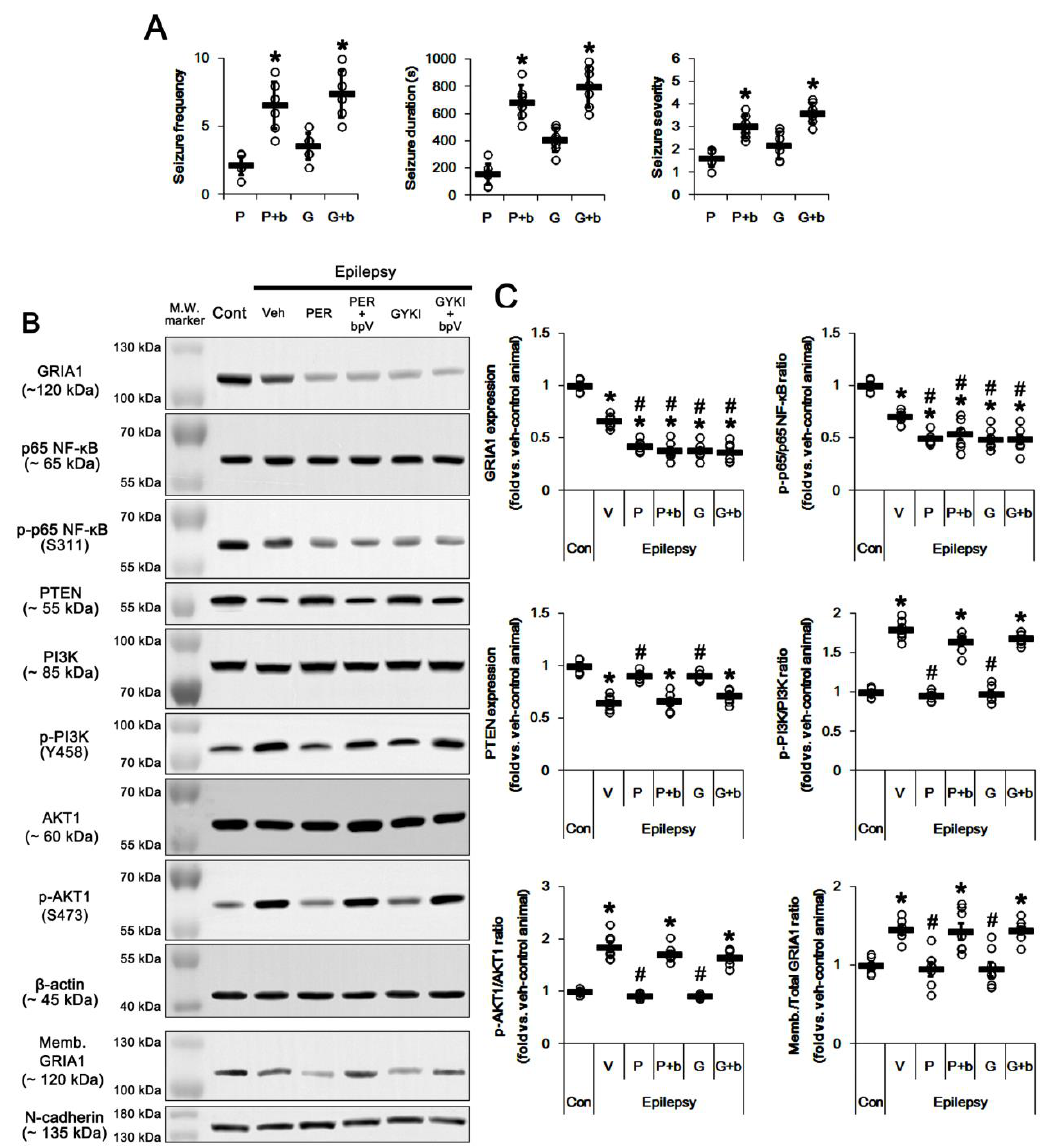
Figure 7. The e ff ect of co-treatment of dipotassium bisperoxovanadium(pic) dihydrate (BpV(pic)) (bpv, b) with perampanel (PER, P) or GYKI 52,466 (GYKI, G) on spontaneous seizure activity, total / membrane GRIA1 expressions, PI3K / AKT1, PTEN, and p65 NF- κ B expressions / phosphorylations in control (cont) and epileptic rats. BpV co-treatment abrogates the e ff ects of perampanel or GYKI 52466. ( A ) Quantitative values of seizure frequency, total seizure duration, and seizure severity during 2 h of recording a day. Open circles indicate each individual value. Horizontal bars indicate mean value. Error bars indicate SD ( * p < 0.05 vs. perampanel- or GYKI 52466-treated animals; Mann–Whitney U-test for seizure frequency and seizure severity; Student’s t -test for seizure duration; n = 7, respectively). (B) Representative images for Western blots concerning GRIA1, p65 NF- κ B, PTEN, PI3K, and AKT1 expressions / phosphorylations. (C) Quantifications of GRIA1, p65 NF- κ B, PTEN, PI3K, and AKT1 expressions / phosphorylations. Open circles indicate each individual value. Horizontal bars indicate mean value. Error bars indicate SEM (*, # p < 0.05 vs. control- and vehicle (Veh)-treated epileptic rats, respectively; one-way ANOVA with post hoc Bonferroni’s multiple comparison; n = 7,